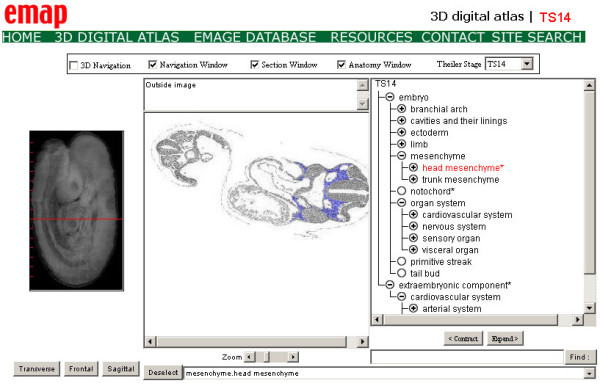
The EMAP anatomy browser. The EMAP Anatomy Browser, showing a 3D reconstruction of the mouse embryo at Theiler Stage 14. Components selected on the 2D section (in blue) are highlighted in the corresponding collapsible text index (in red) for that stage. Even with some levels collapsed the inability to obtain an overview of the entire data set can be seen.